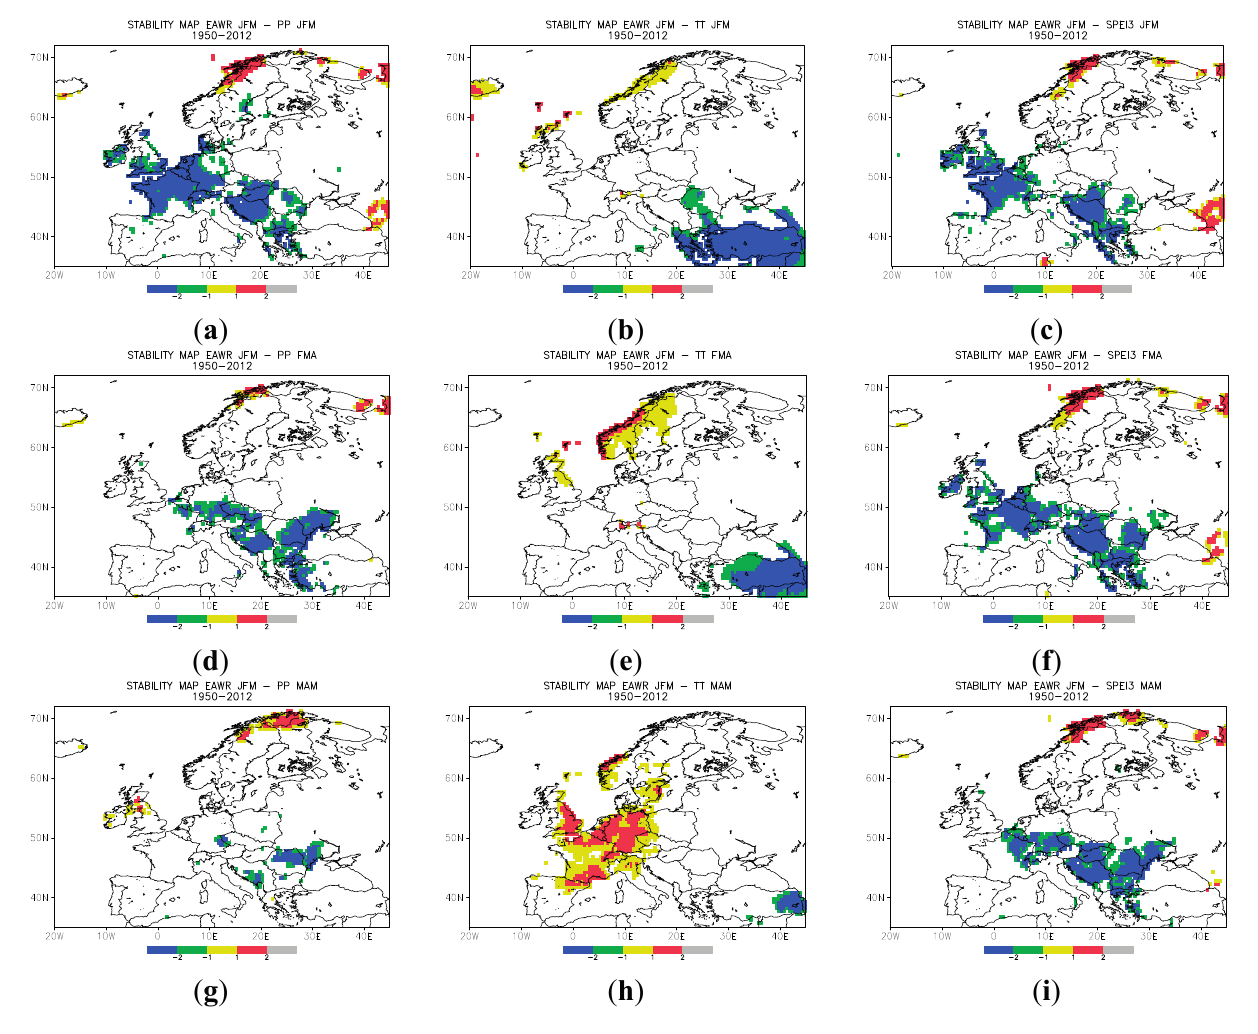
Figure 8. Stability maps of the correlation between JFM EAWR and Precipitation (first column), Temperature (second column) and SPEI3 (third column) for ( a – c ) January to March; ( d – f ) February to April and ( g – i ) March to May. Regions where the correlation is stable, positive, and significant at the 90% (80%) level for at least 80% of the windows are shaded red (yellow). The corresponding regions where the correlation is stable but negative are shaded blue